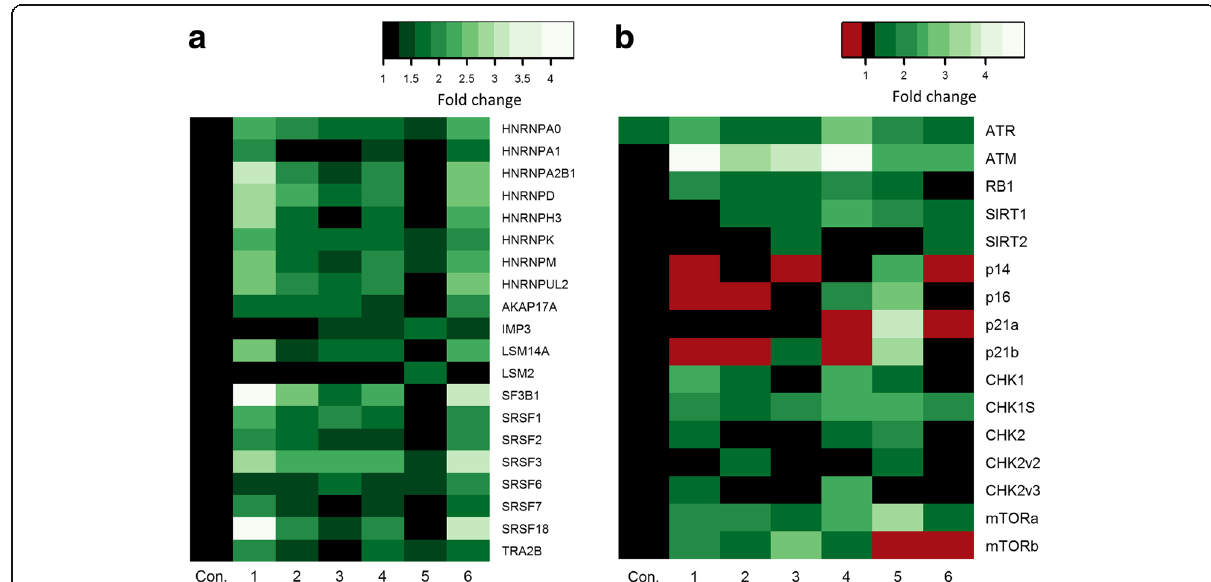
Fig. 3 Splicing factor regulators are elevated following treatment with resveratrol analogues. Changes to mRNA levels in HNDF cells in response to treatment with 5 μ M resveratrol ( 1 ) or resveralogues 2 – 6 determined by quantitative reverse transcription PCR. a Expression of splicing factor regulatory genes ( b ) Isoform-specific transcripts of genes associated with senescence and/or DNA damage responses. Con = control (vehicle only). Green indicates up-regulated genes, red denotes down-regulated genes. The colour scale refers to fold-change in expression. Data are derived from duplicate testing of 3 biological